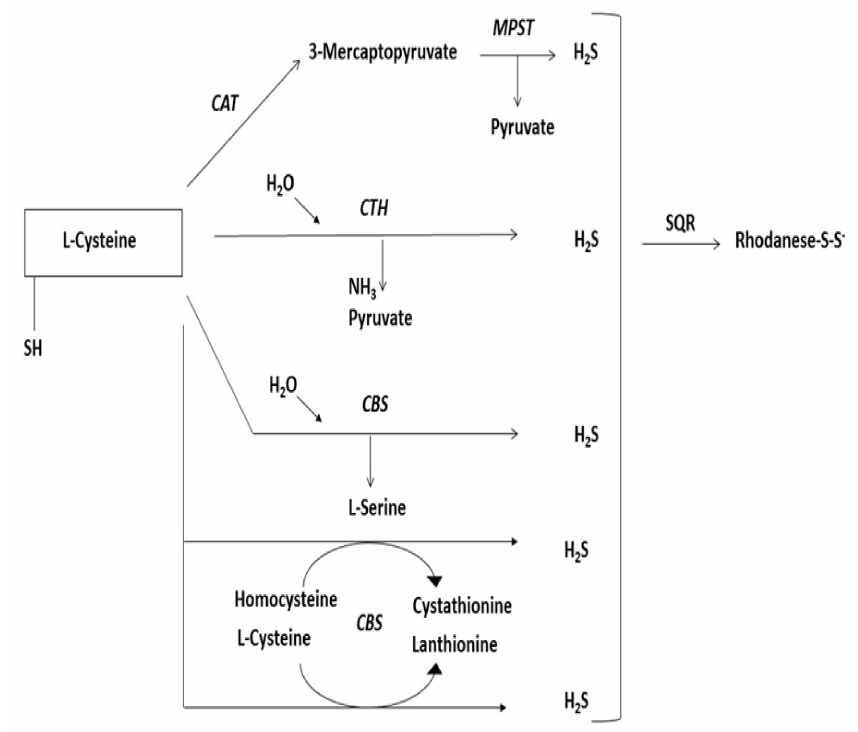
Figure 6. Schematic diagram showing the L-cysteine desulfuration pathway resulting H 2 S release. CAT, cysteine aminotransferase, MPST, 3-mercaptopyruvate sulfurtransferase, CTH, cystathionine γ -lyase, CBS, cystathionine- β -synthase, SQR, sulfide quinone